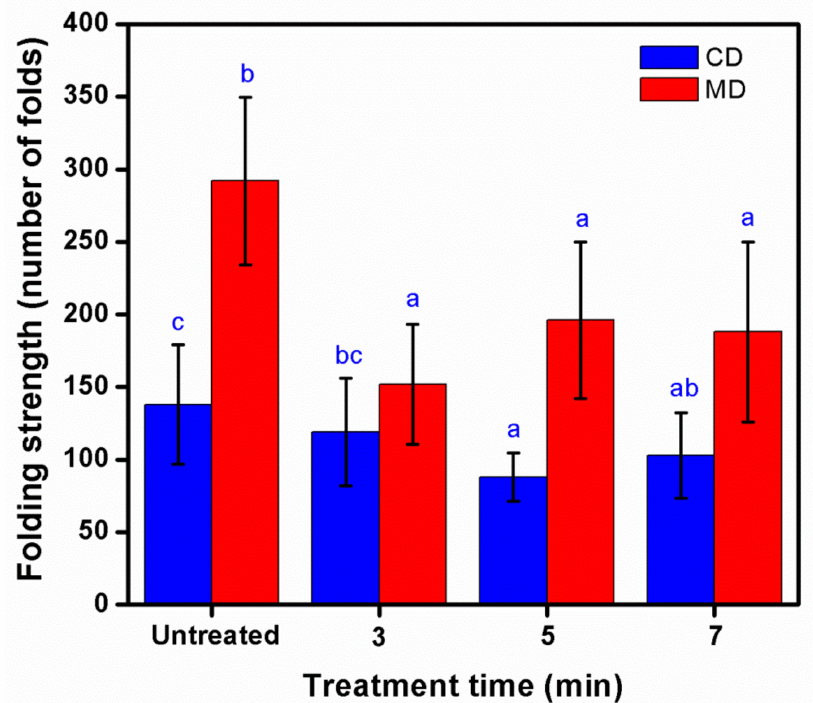
Figure 9. Effect of treatment time on folding strength (double folds) of untreated and treated KPs with plasma at 200 mTorr and 50 Watts (MD—machine direction, CD—cross direction). Note: values indicated with the same letters are not significantly different at p <